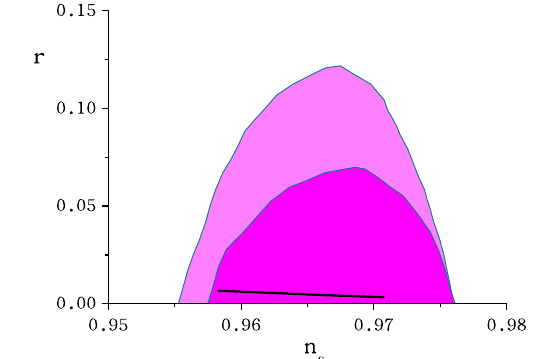
Fig. 3 1 σ (magenta) and 2 σ (light magenta) contours for Planck 2018 results (Planck + TT + lo w P ) [87], on n s − r plane. Additionally, we presentthepredictionsofthescalefactorpotential(32)with50 ≤ N f ≤ 70, according to (38) ( n s = 0 . 9584 for N f = 50 and n s = 0 . 9706 for = 70) N f